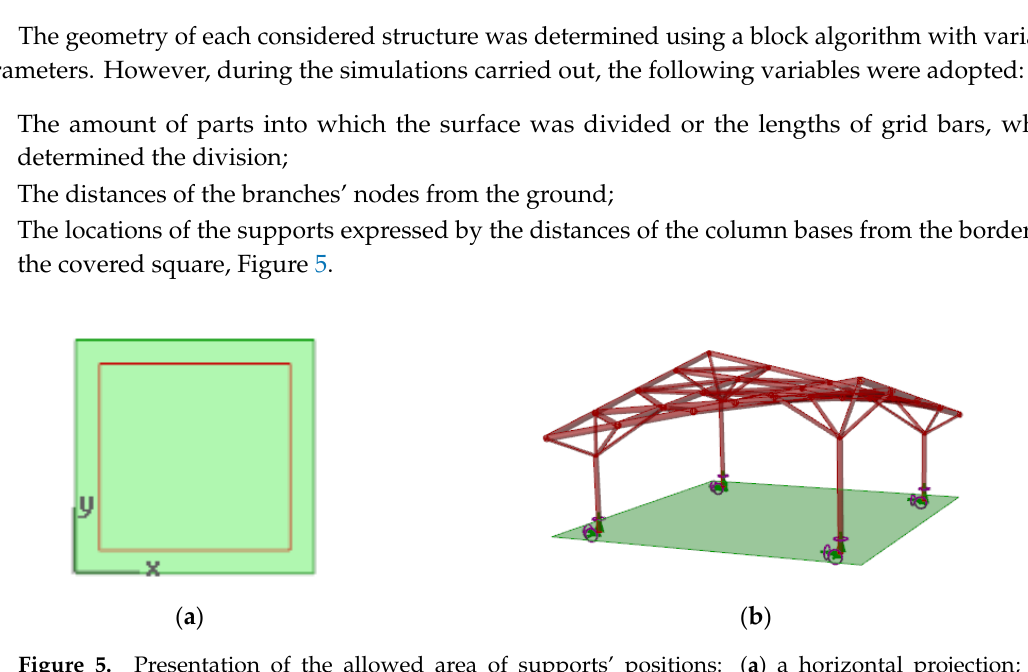
Figure 5. Presentation of the allowed area of supports' positions: ( a ) a horizontal projection; ( b ) a perspective view